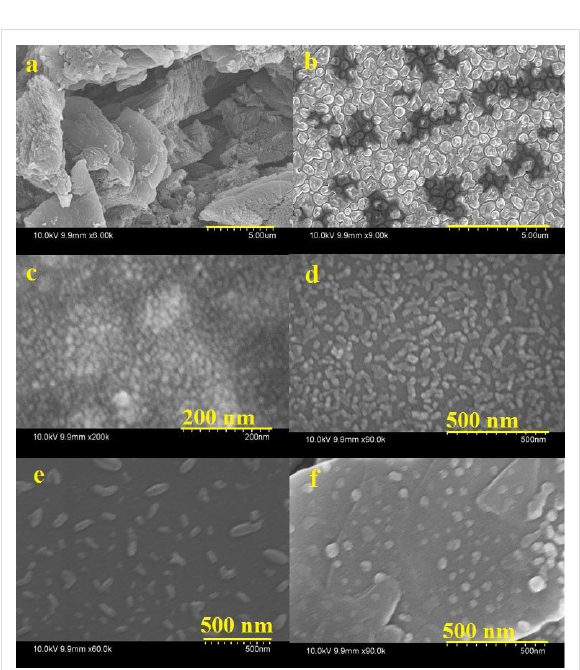
Figure 8: Field emission scanning electron microscopy images of the a) g-C 3 N 4 nanosheet, b) after acid treatment of g-C 3 N 4 , c) CN-5 quan- tum dots, d) CN-10 nanoflakes, e) CN-20 nanoflakes and f) the GCN-5 material.